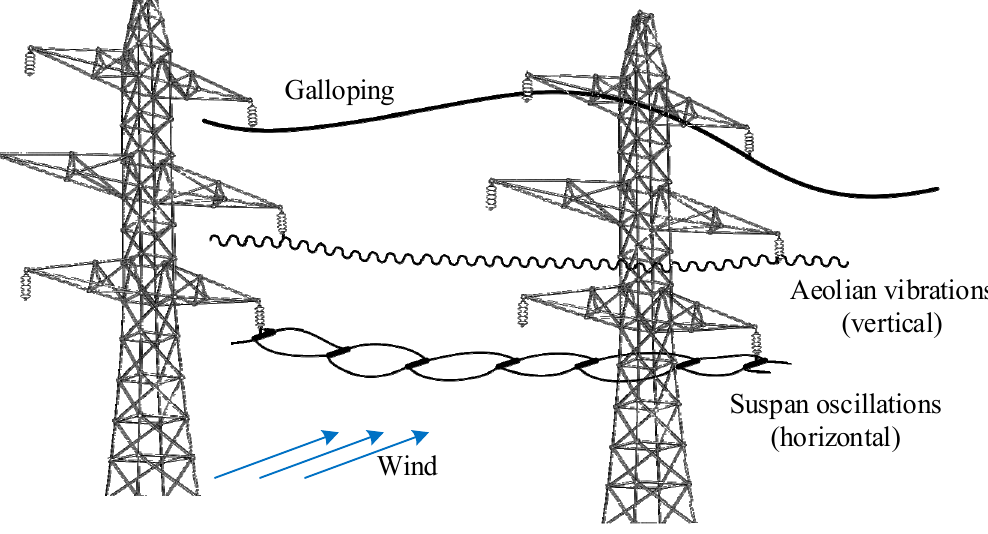
Figure 1. Typical motion shapes of the different wind-induced phenomena acting on HVTL conductors.